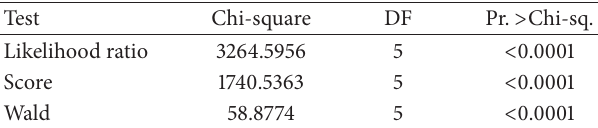
Table 6: Testing global null hypothesis.